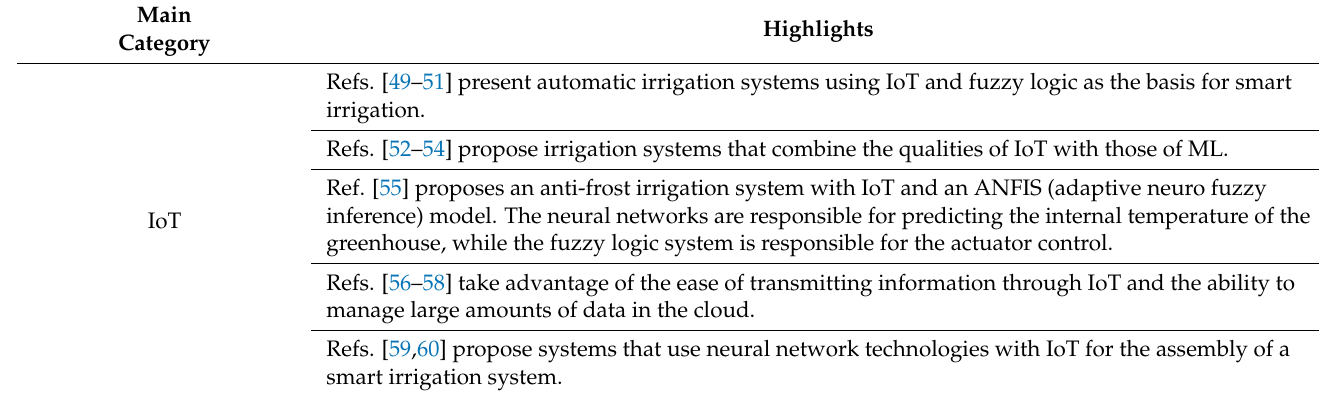
Table 5. The highlights of the different